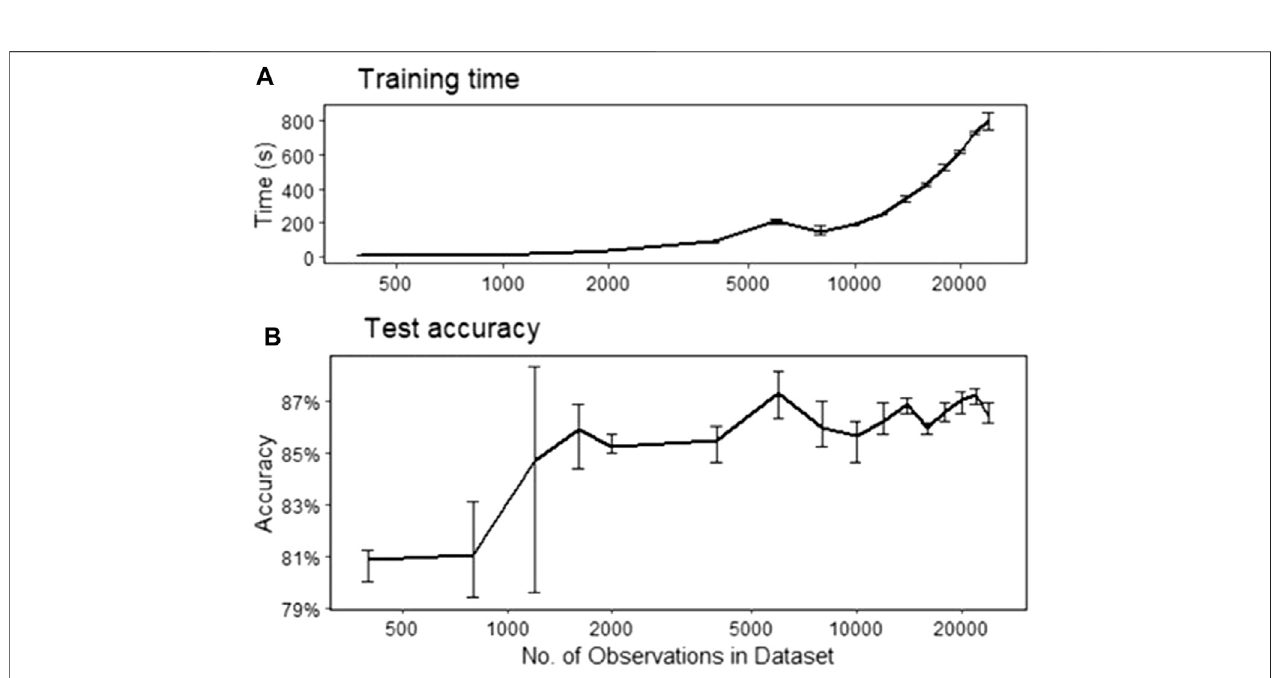
FIGURE6| Numberofobservations intraining datavstrainingtime (A) and testing accuracy (B) .Error bars represent minimum andmaximum ofthree trials.Note: the horizontal axis is in log scale.